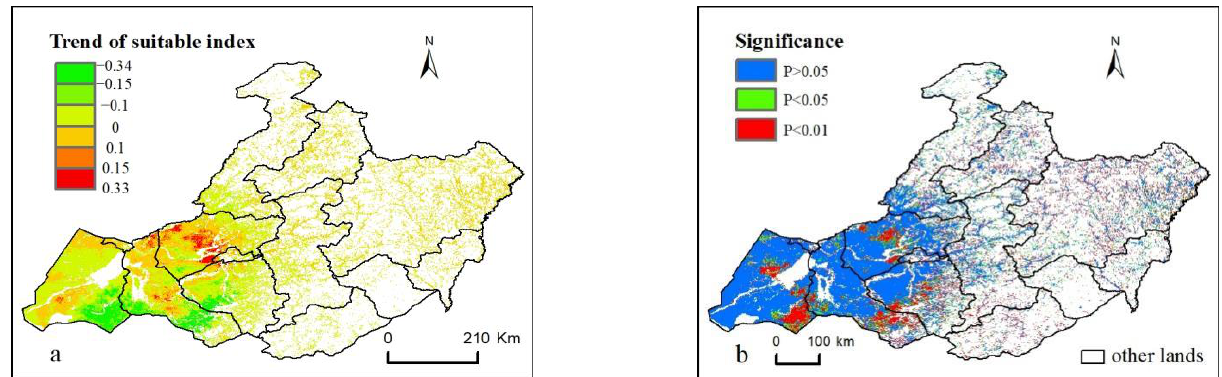
Figure 5. Trend of the grasshopper suitability index ( a ) and F test ( b ) in Hulunbuir grassland from